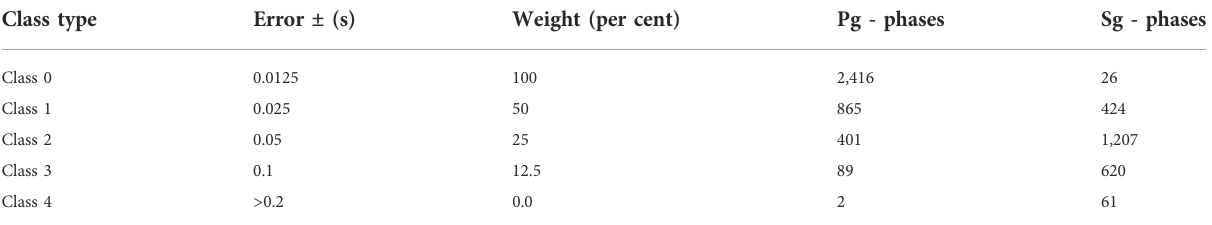
TABLE 1 Pick-quality weighting scheme and number of manual picks used for the computation of the minimum 1-D and 3-D velocity models, respectively, of the Hengill geothermal fi eld.